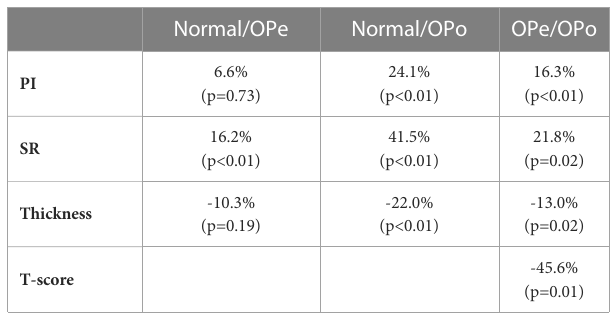
TABLE 2 Percentage difference in PI, SR, bone thickness, and T-score values between the studied groups.